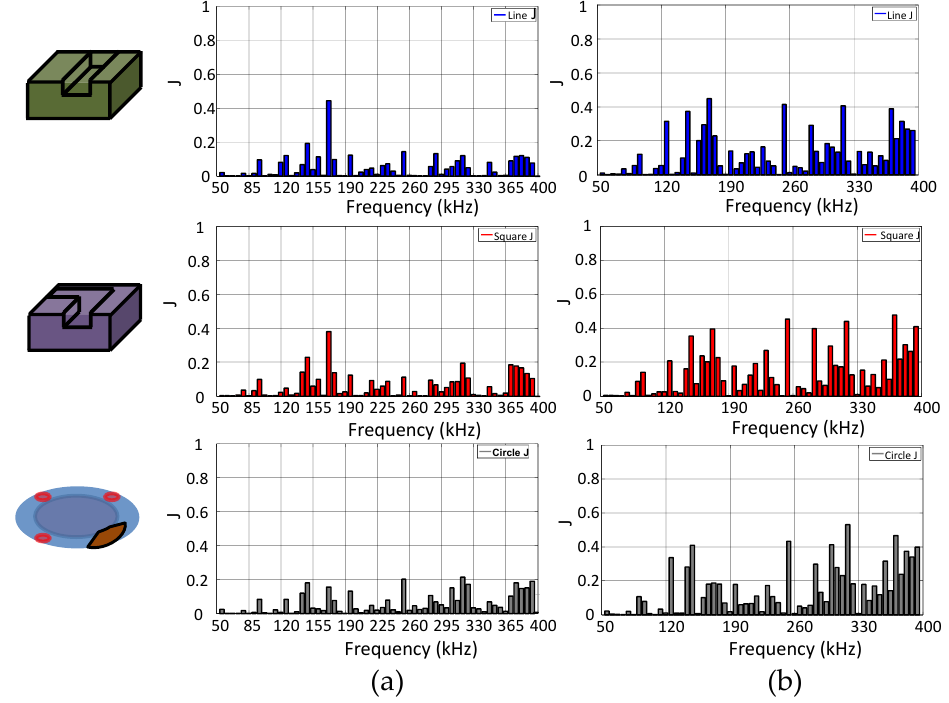
Figure 14. Classification index J with various AE signal lengths for feature generation: ( a ) 0.015 s; ( b ) 0.22 s.